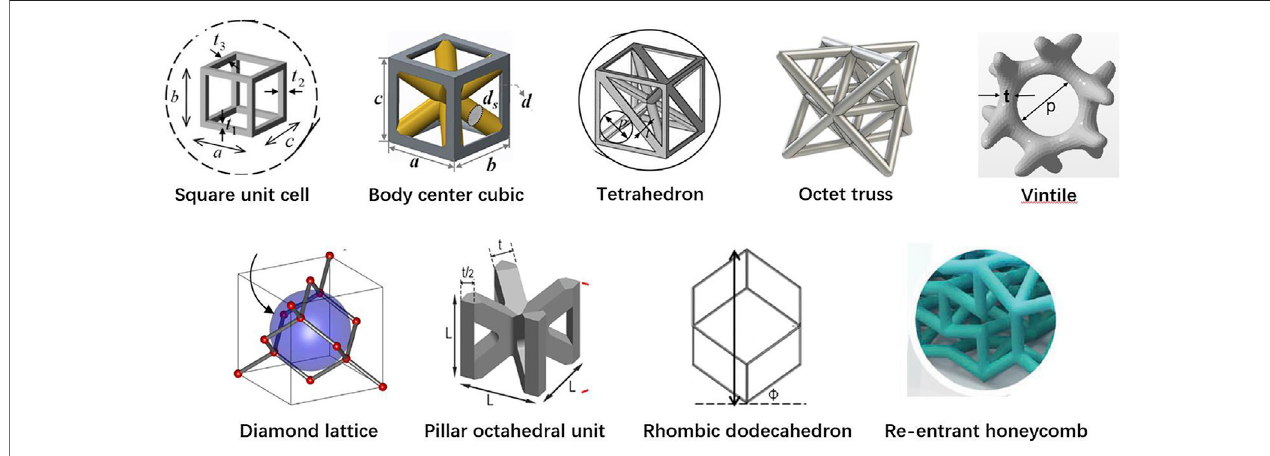
FIGURE 2 | Regular porous structures used in the design of femoral stems.